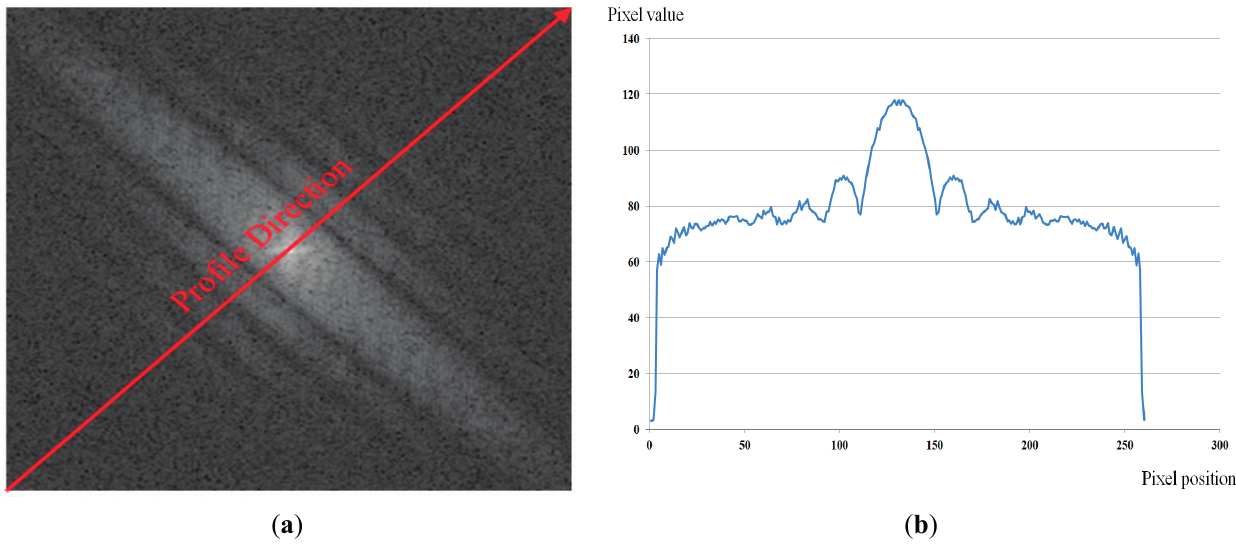
Figure 8. Example of profile in motion direction where motion direction is 135° and amount of motion blur is 9: ( a ) power-spectrum image; and ( b ) profile in motion